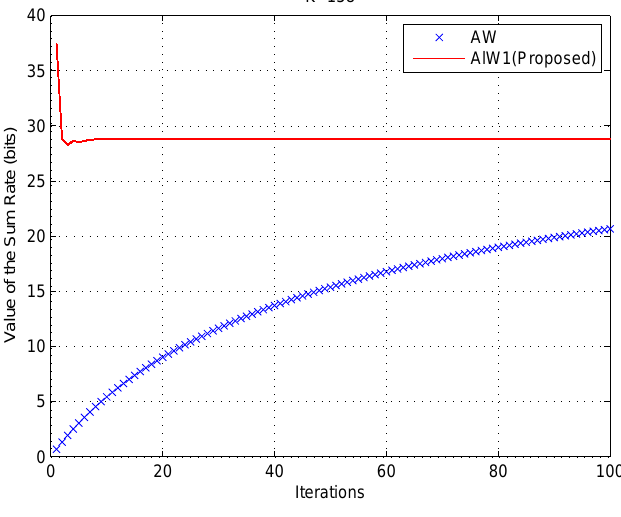
Figure 9. Algorithm ALW1 compared with Algorithm AW, as K